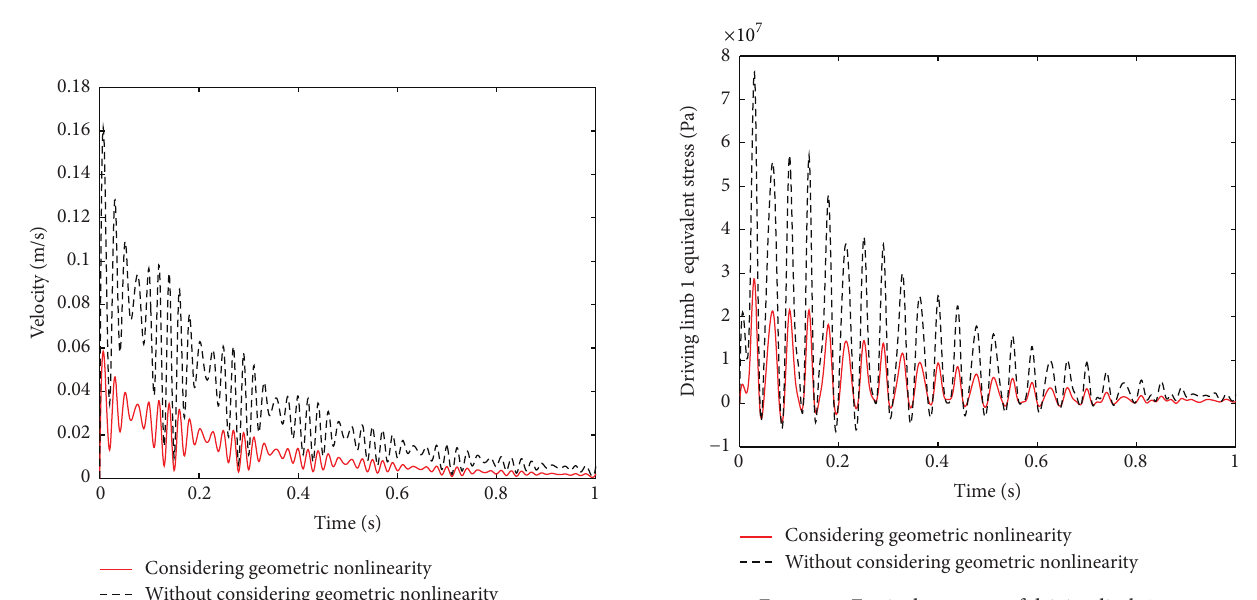
Figure 4: Displacement error output of moving platform.